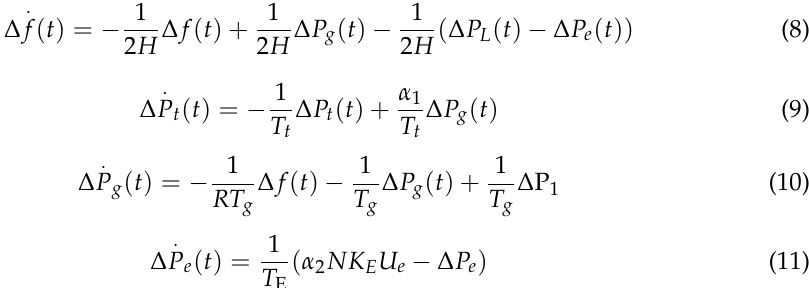
Figure 4. LFC–EVs model for frequency response.